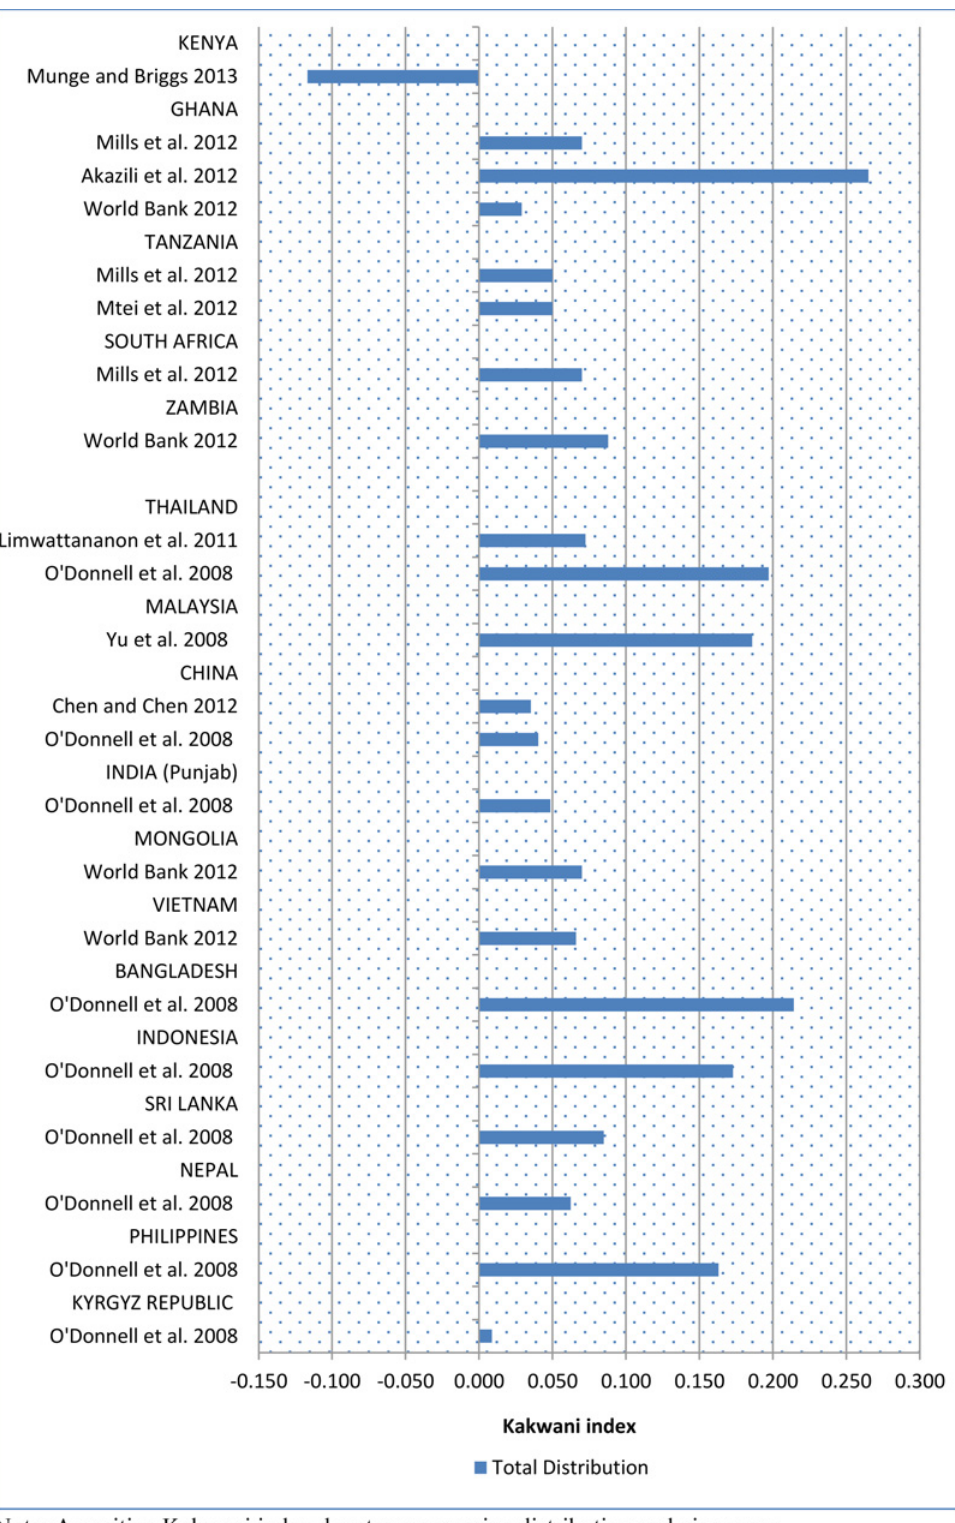
Fig 4. Kakwani index of total distribution of health care payments reported by FIA studies from sub-Saharan Africa and Asia-Pacific.